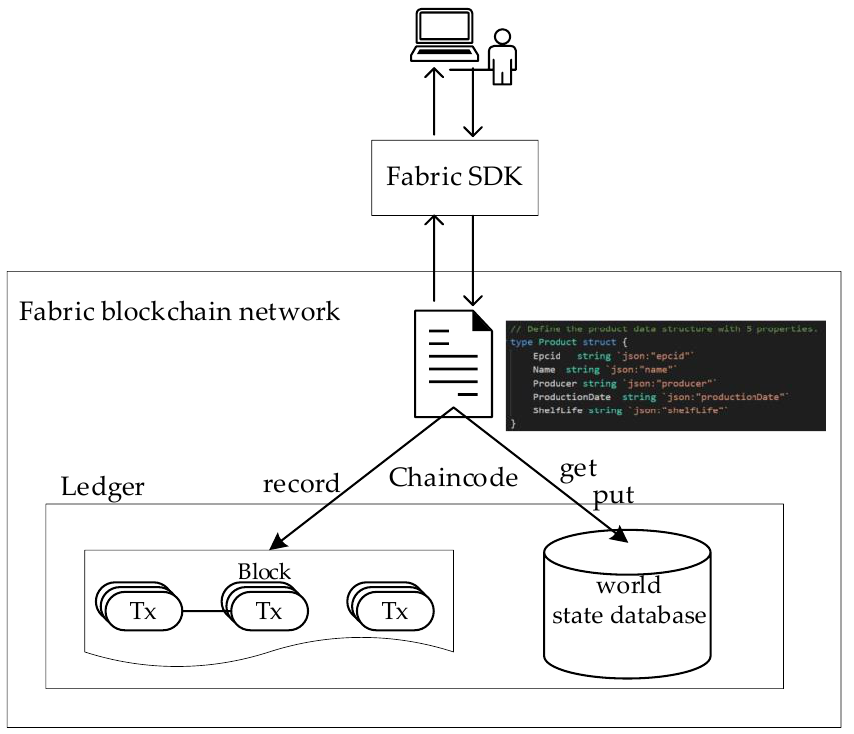
Figure 6. The Fabric network interacts with the client using Chaincode.